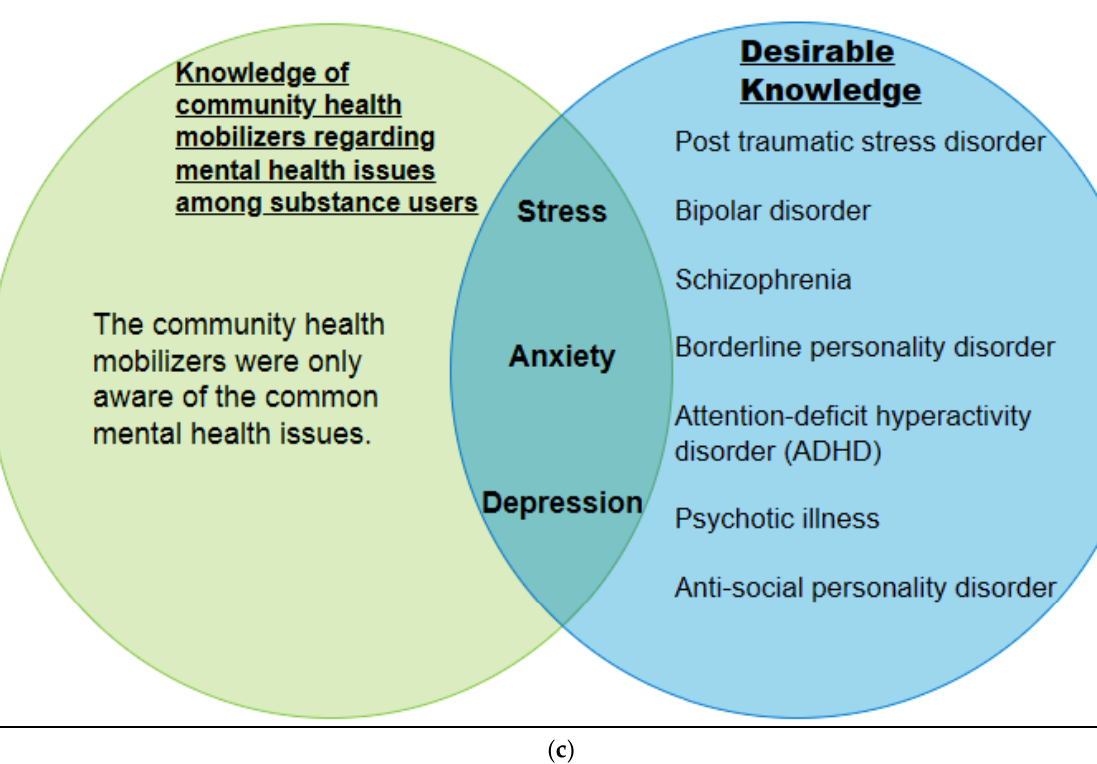
Figure 3. Venn diagrams showing major areas of knowledge gaps in community health mobilizers regarding ( a ) sexualize substances, ( b ) health problems and ( c ) psychological issues associated with sexualized substance use. The overlapping regions of the circles represent the desirable knowledge that the community health mobilizers possessed.